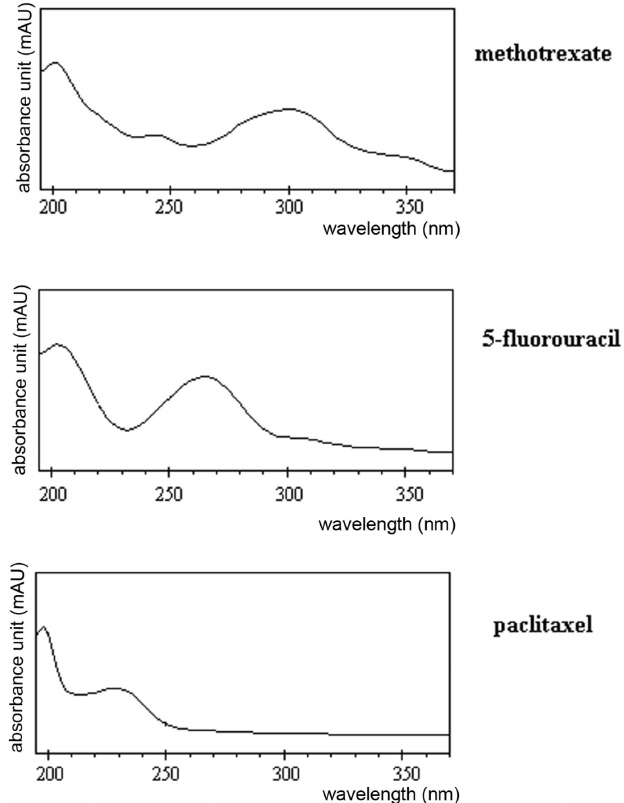
FIGURE 2 - Spectra from a Shimadzu SPD-M10Avp (Kyoto, Japan) diode array detector, for standard solutions of methotrexate, 5-fluorouracil and paclitaxel (5 µg mL -1 ); mobile phase: water (pH 4)-methanol-acetonitrile (35:15:50, v/v/v); column: Supelcosil TM LC-18 (250 x 4.6 mm, 5 m m) protected by a C18 guard-column (4 x 4.6 mm, 5 m m).